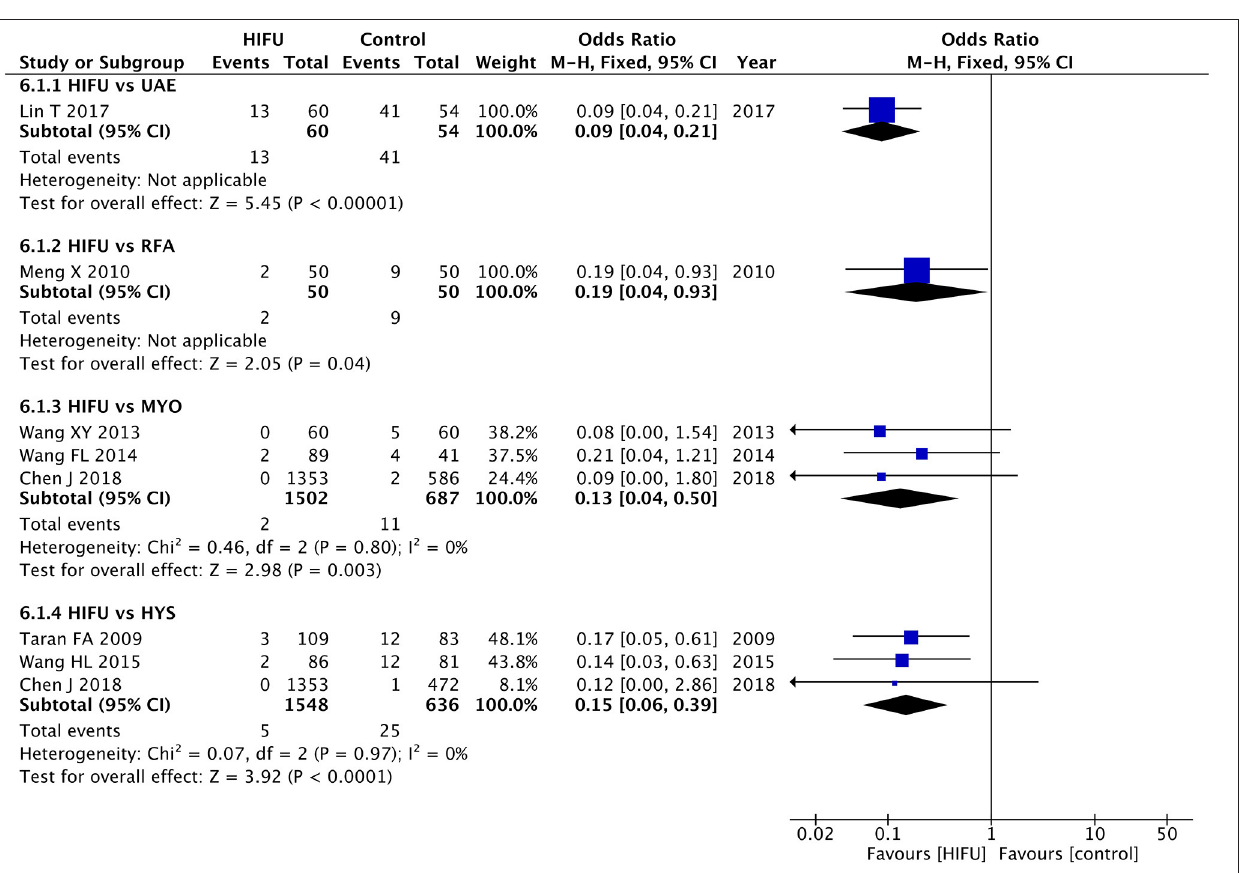
FIGURE 5 | Fever incidence of HIFU in comparison with other techniques.